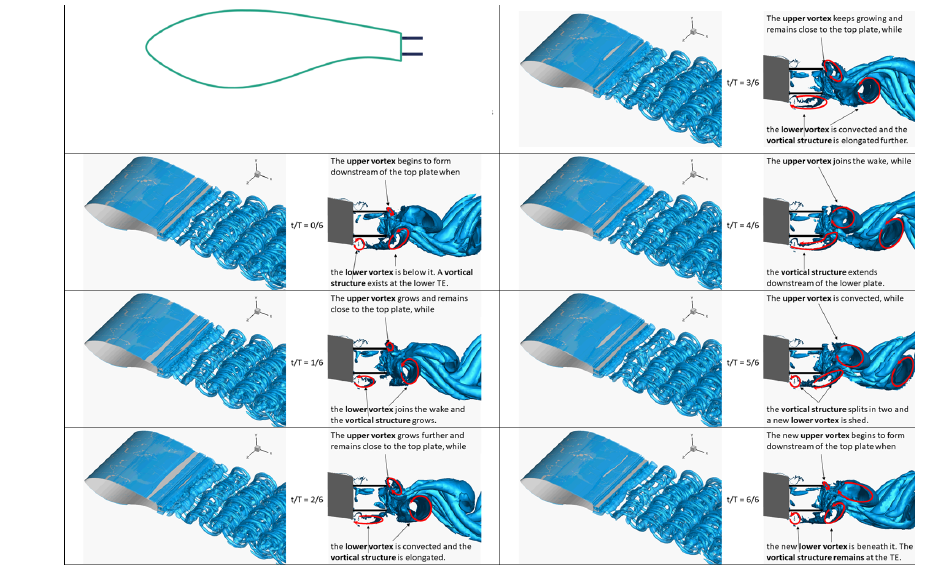
Figure A3. Snapshots of Q isosurfaces from the offset cavity case: IDDES fine-mesh results. Each period of the vortex shedding mechanism is split into six parts, and a total of seven snapshots is shown. For each snapshot, two visualisations are shown. A 3D view of Q = 1 . 5 isosurfaces is shown on the left, and a side view of Q = 100 isosurfaces is shown on the right. Superimposed red arrows indicate interpreted spanwise vortices.